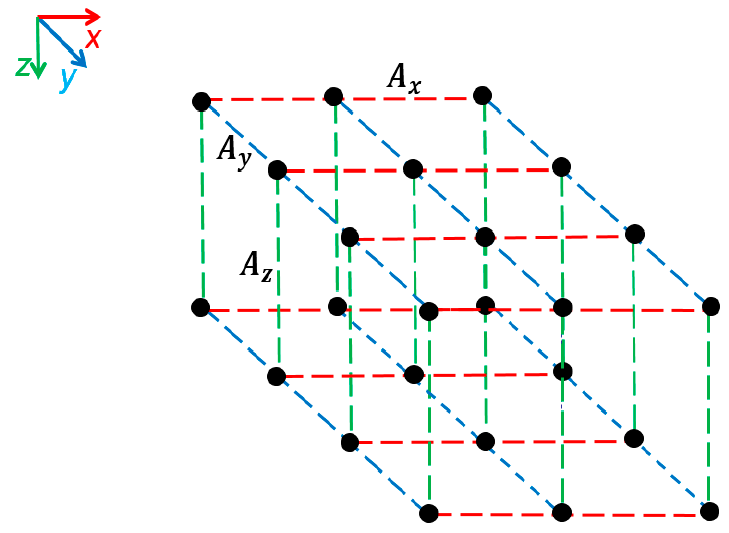
Figure 1. The finite volume grid discretization for the system of equation.